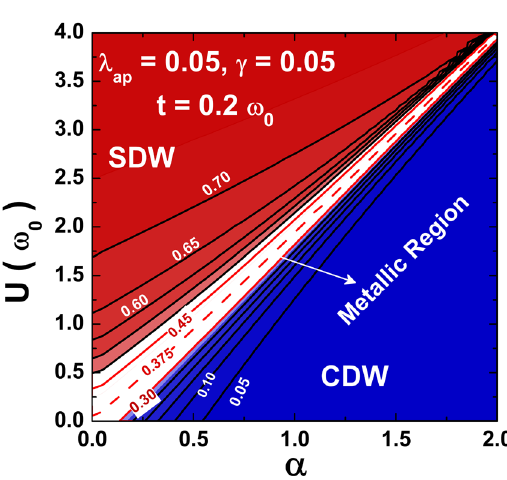
Figure 8. Contour plots of L 0 in α - U plane.